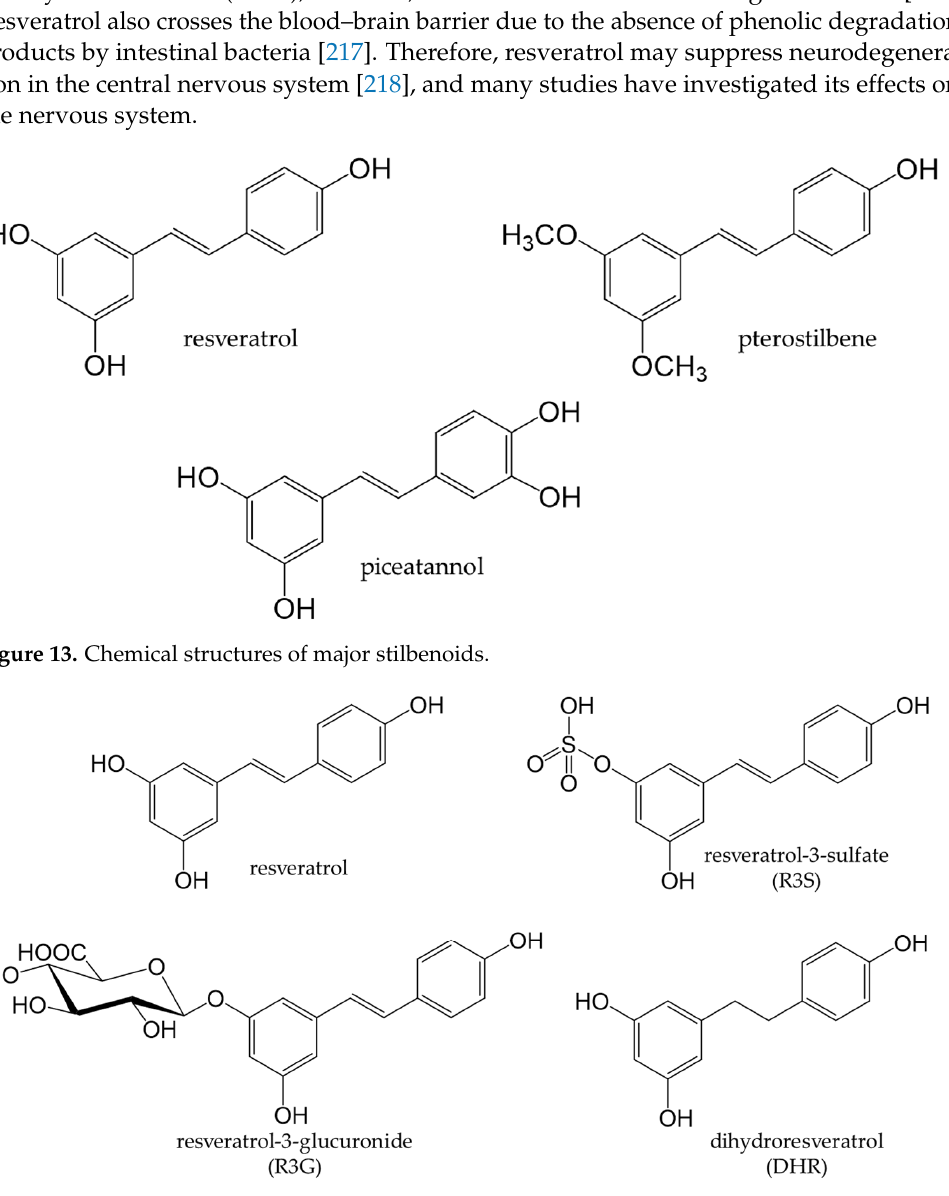
Figure 14. Chemical structures of resveratrol metabolites.